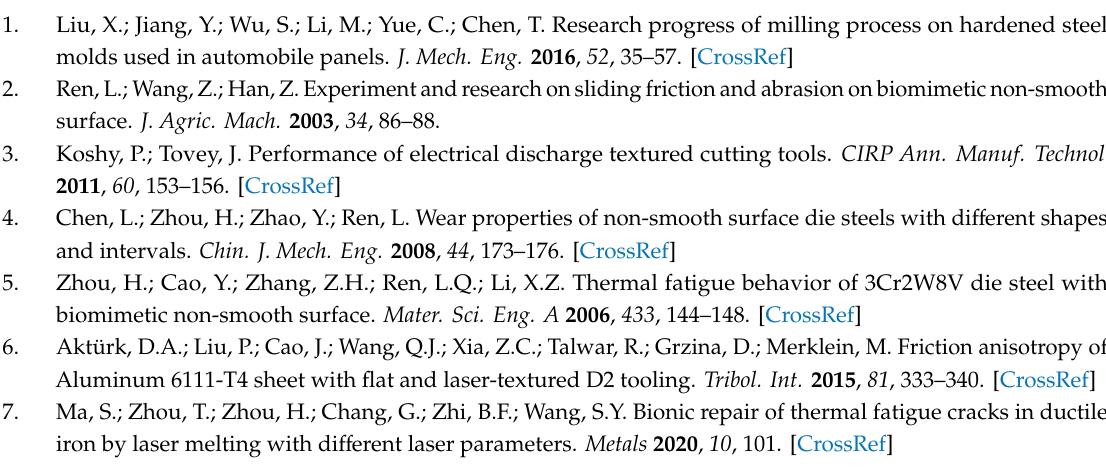
Figure S1: nephograms of fatigue life. (a) A1 model; (b) A2 model; (c) A3 model; (d) A4 model; (e) A6 model, (f) A5 model, Figure S2: nephograms of fatigue life. (a) F1 model; (b) F2 model; (c) F3 model; (d) F4 model; (e) F6 model, (f) F5 model, Figure S3: nephograms of fatigue life. (a) S1 model; (b) S2 model; (c) S3 model; (d) S4